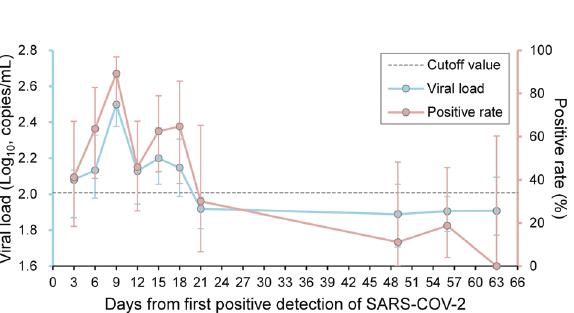
Fig. 3 Dynamic pro fi le of viral loads and positive rates in asymptomatic individuals with SARS-CoV-2 infection. The blue line represents dynamic pro fi le of viral loads (mean and standard deviation) based on N gene of SARS-CoV-2 in the saliva samples. The pink line represents dynamic pro fi le of positive rates (rate and 95% con fi dence